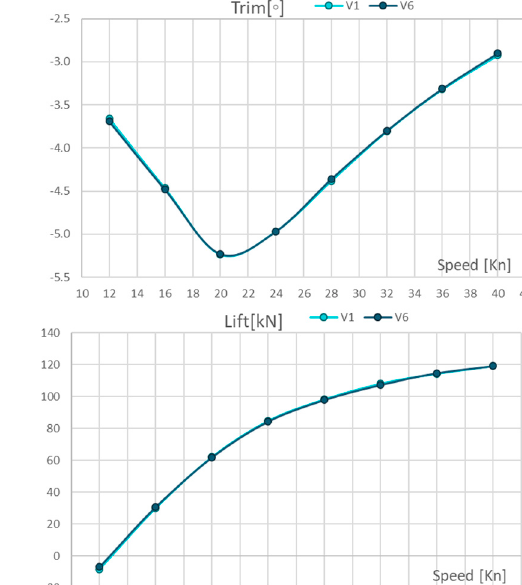
Figure 12. Forces and pressure distributions comparison for V4 and V6, at 36 and 40 kn.